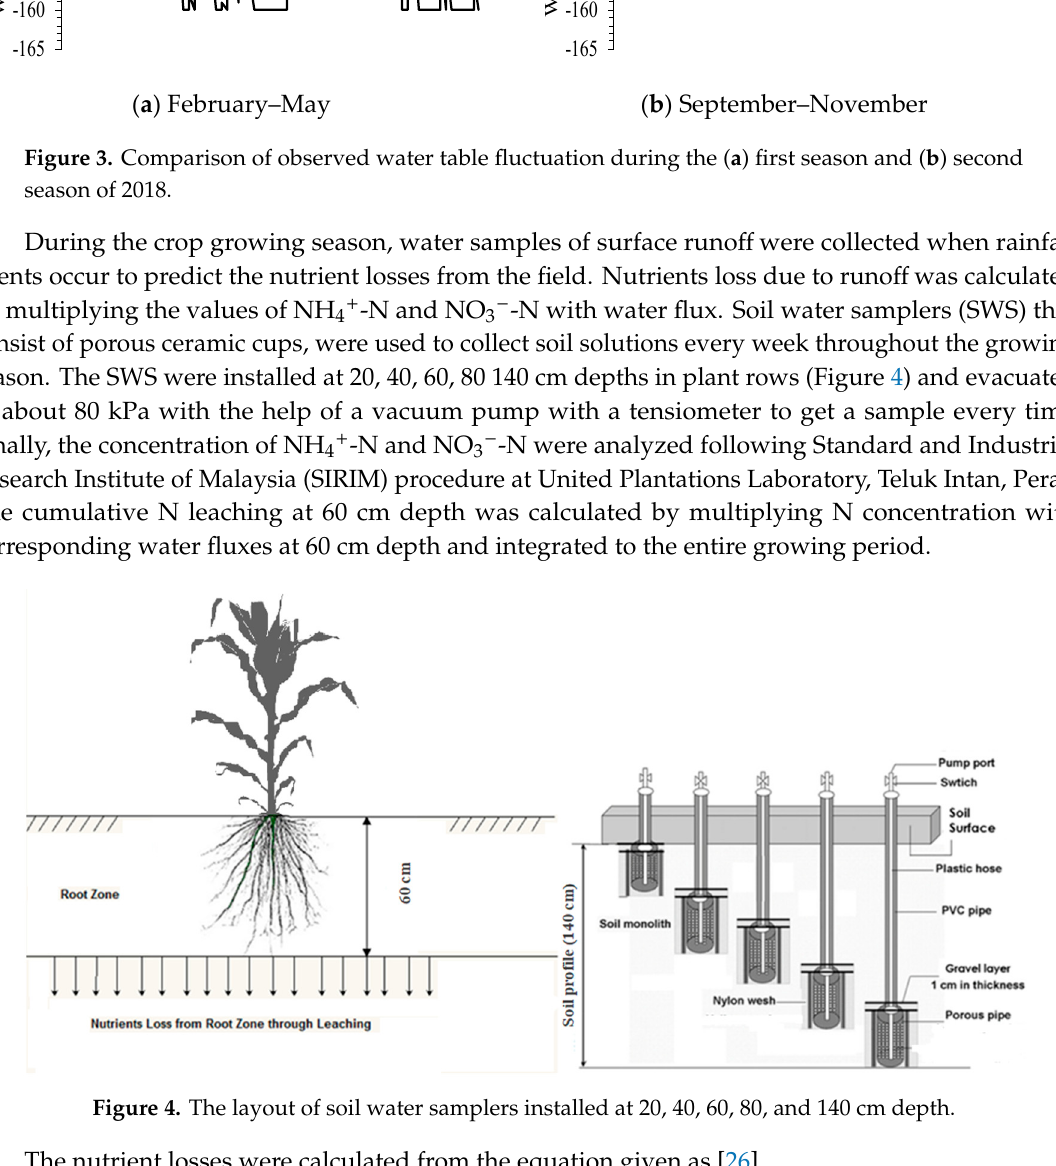
Figure 3. Comparison of observed water table fluctuation during the ( a ) first season and ( b ) second season of 2018.